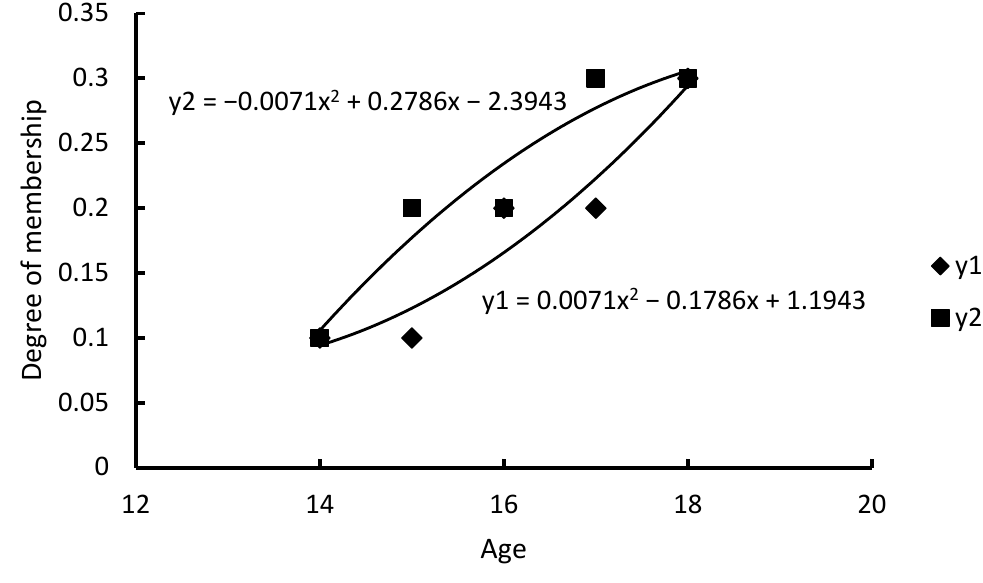
Figure 2. Single factor evaluation for 14–18 years old. where y 1 = 0.0018 x 2 − 0.0607 x + 0.7943, y 2 = 0.3. Then y 3 = − 0.0018 x 2 + 0.0607 x − 0.0943 is calculated by Equation